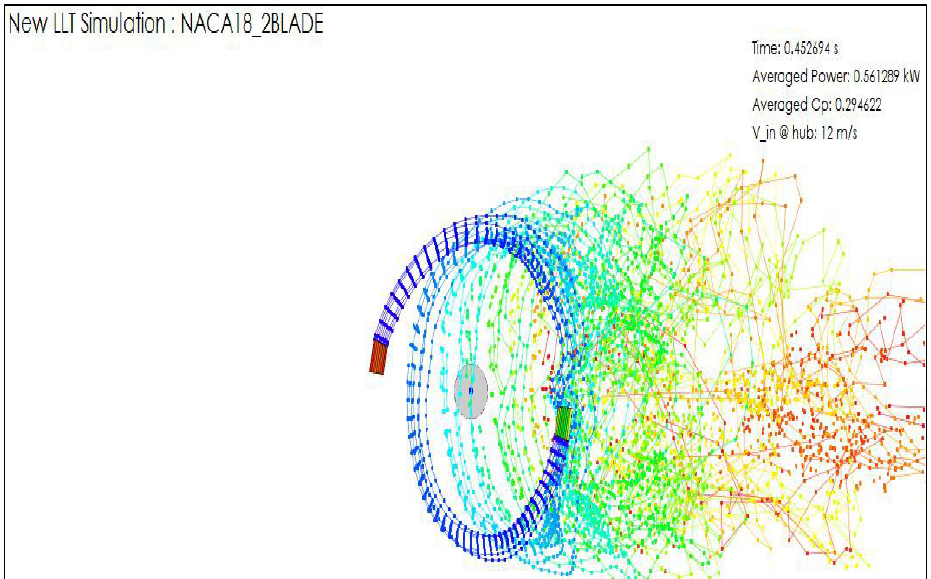
Figure 47. Two-bladed vortex simulation